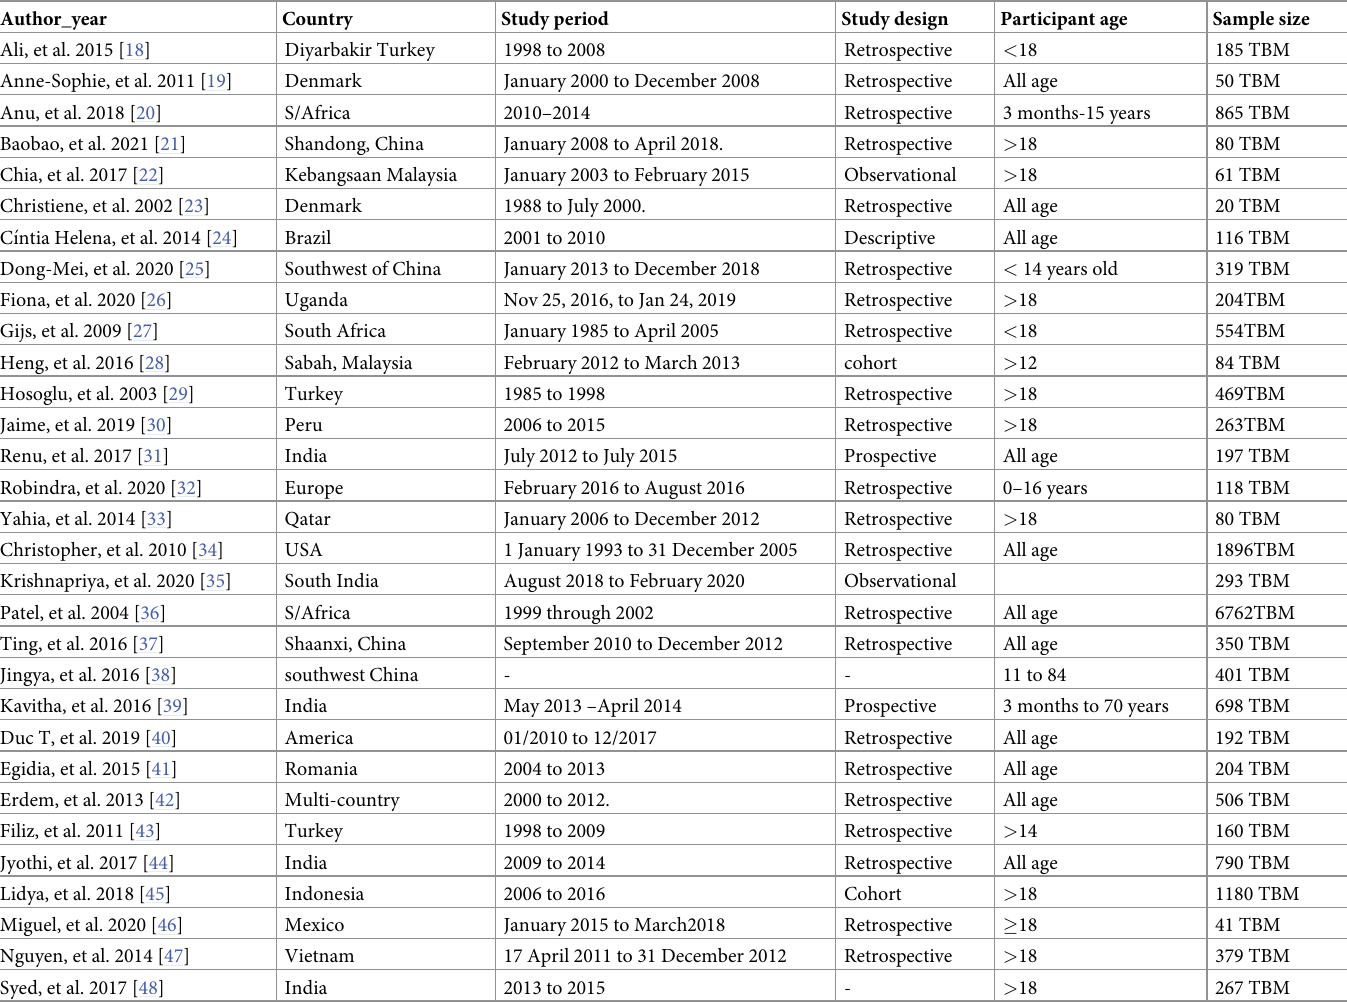
Table 1. Study characteristic of included